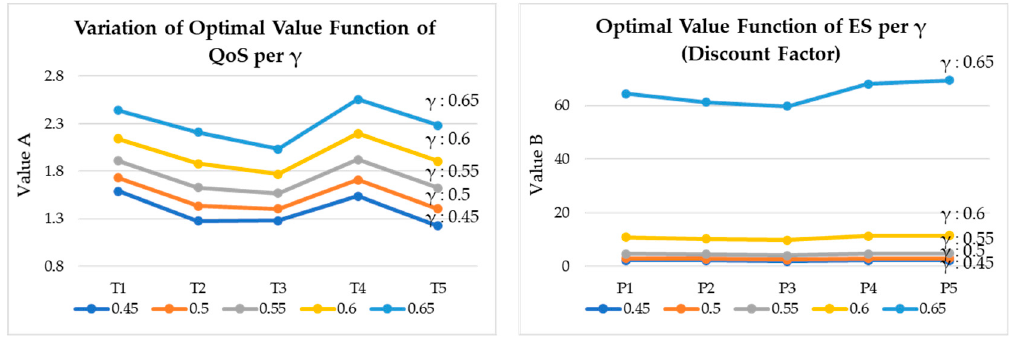
Figure 15. Estimated optimal values of QoS and energy saving per 𝛾 (Discount Factor).